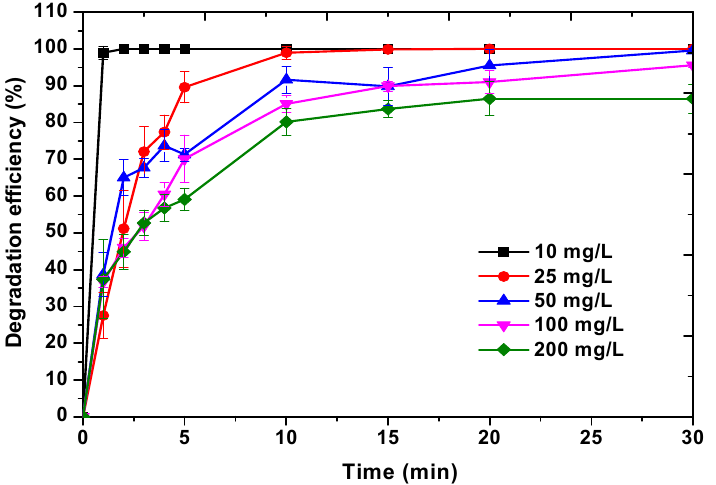
Figure 7. Degradation efficiencies of methyl orange dye using 10 mg Fe/Cu/Ag 5:1:0.2 nanoparticles with different initial MO concentrations (pH ~ 4.5) at room temperature.